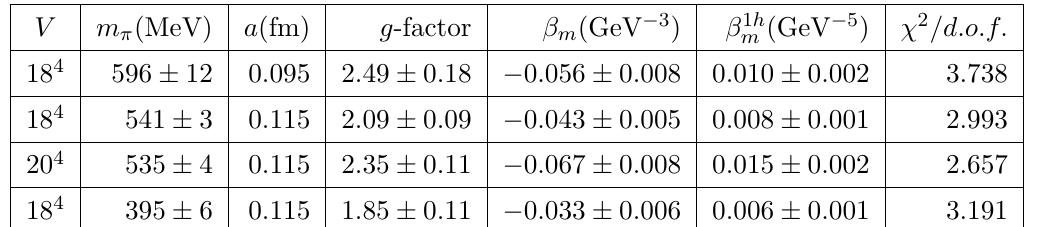
Table 6. The magnetic dipole moment, the magnetic dipole polarizability and magnetic hyper- polarizability of the (cid:12)rst order (cid:12) 1 h and second order (cid:12) 2 h of the charged (cid:26) meson for the lattice m m spacings 0 : 095 fm, 0 : 115 fm, the lattice volume 18 4 , various pion masses and for the lattice spacing 0 : 115 fm, the lattice volume 20 4 and the pion mass m (cid:25) = 535(4) MeV with their errors and (cid:31) 2 =d:o:f values. The results were obtained with the use of 4-parametric (cid:12)t (4.2).